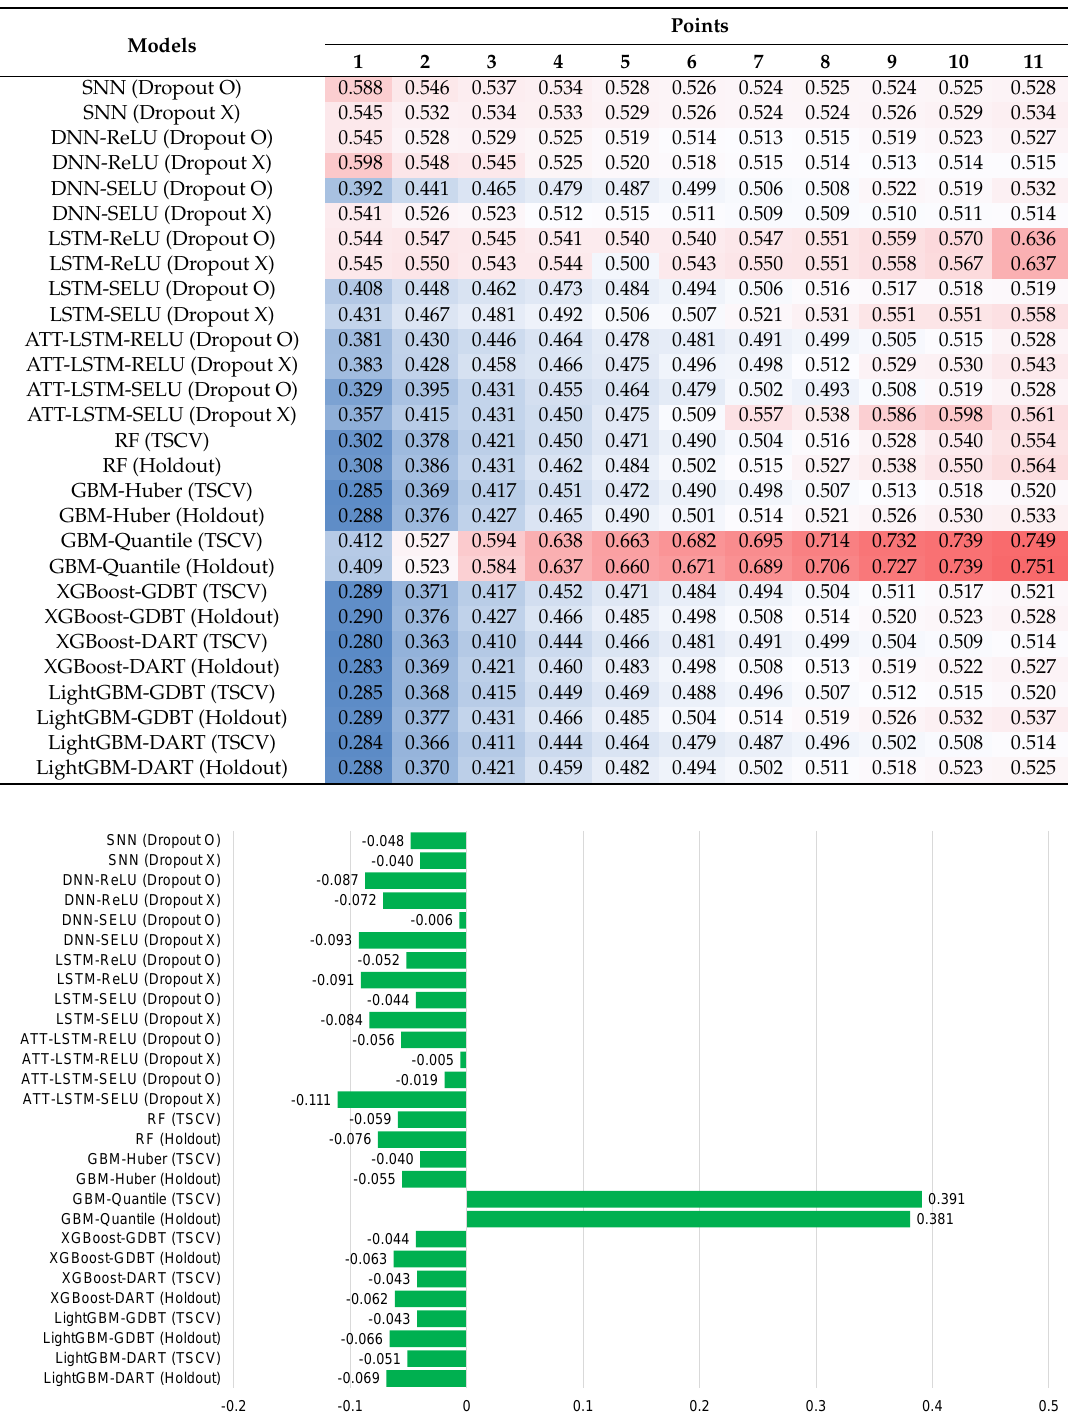
Table 7. Root mean square error (RMSE) distribution for each model for Ildo-1. A cooler color indicates a lower RMSE value, whereas a warmer color indicates a higher RMSE value (MJ/m 2 ).